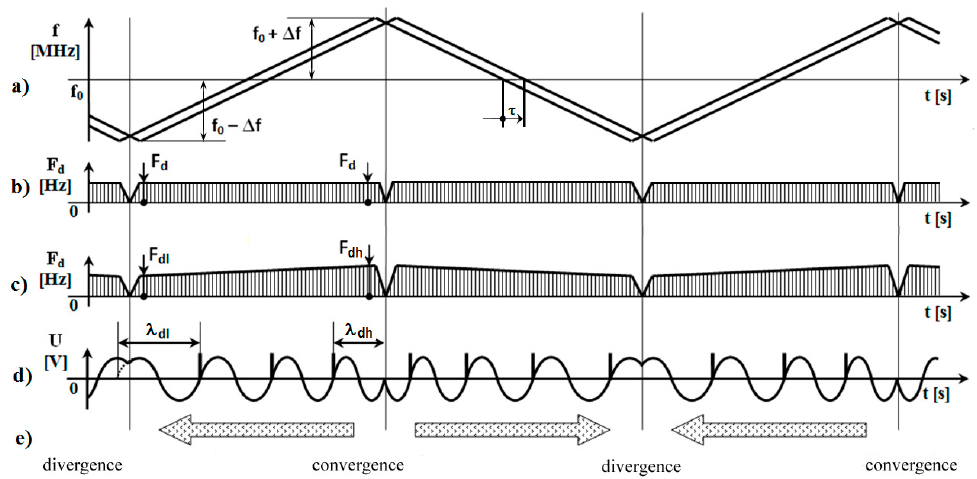
Figure 4. Formation of di ff erential signal for determination of the number of unstable height pulses. ( a ) frequency-modulated transmitted signal, and received signal with the delayed in time by τ ; ( b ) theoretical representation of the di ff erential frequency over time; ( c ) actual change of the di ff erential frequency over time; ( d ) change of the period of the di ff erential frequency within the modulation frequency; ( e ) temporary shift of the periods of the di ff erential frequency with increasing the measured altitude.